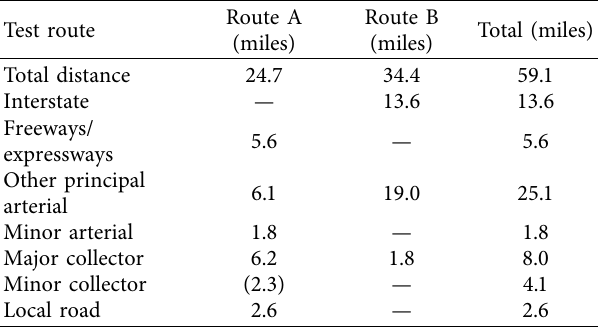
Table 3: Distance covered on each road